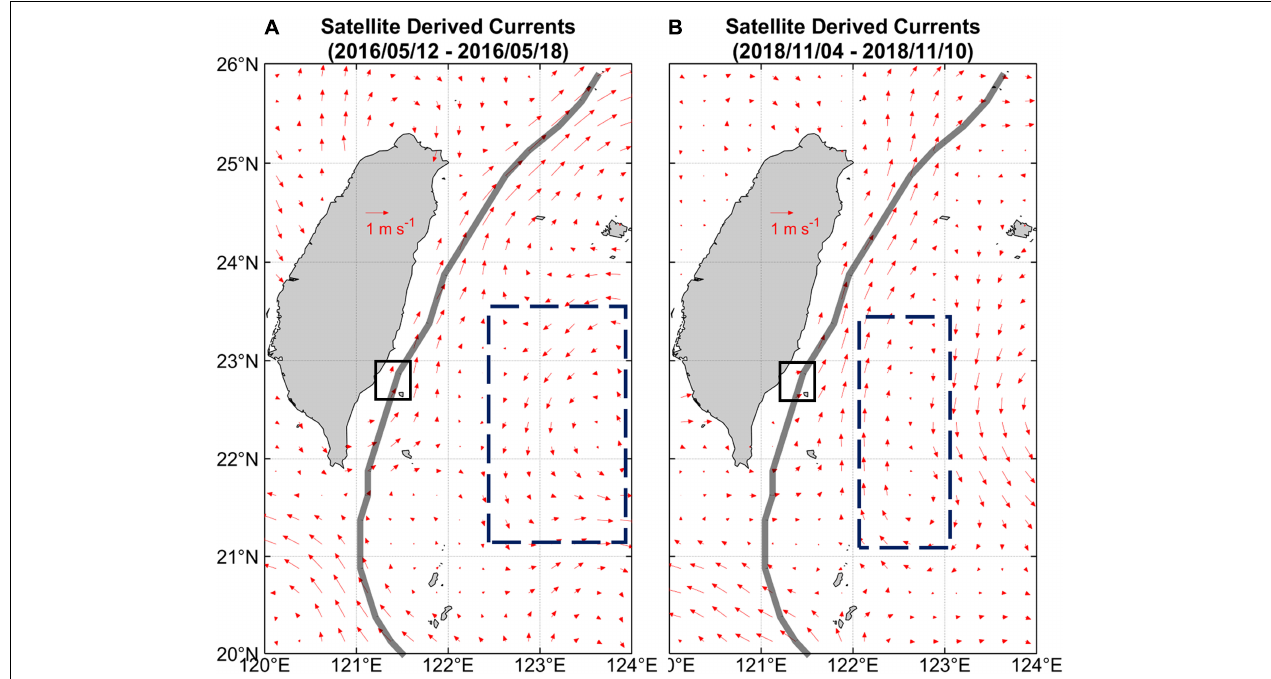
FIGURE 2 | Flow patterns of geostrophic currents (red arrows) during surveys in May 2016 (A) and November 2018 (B) . The axis of Kuroshio was close to the coast of Taiwan in both surveys and was directly flowing along the K seamount (black box). In 2016, the Kuroshio intrusion into the South China Sea followed a looping path and a cyclonic eddy existed to the east of the Kuroshio. In 2018, an anti-cyclonic eddy existed to the east of the Kuroshio, which could be expected to add to the current velocity. These eddies are highlighted along the east of the Kuroshio by boxes with dashed lines.